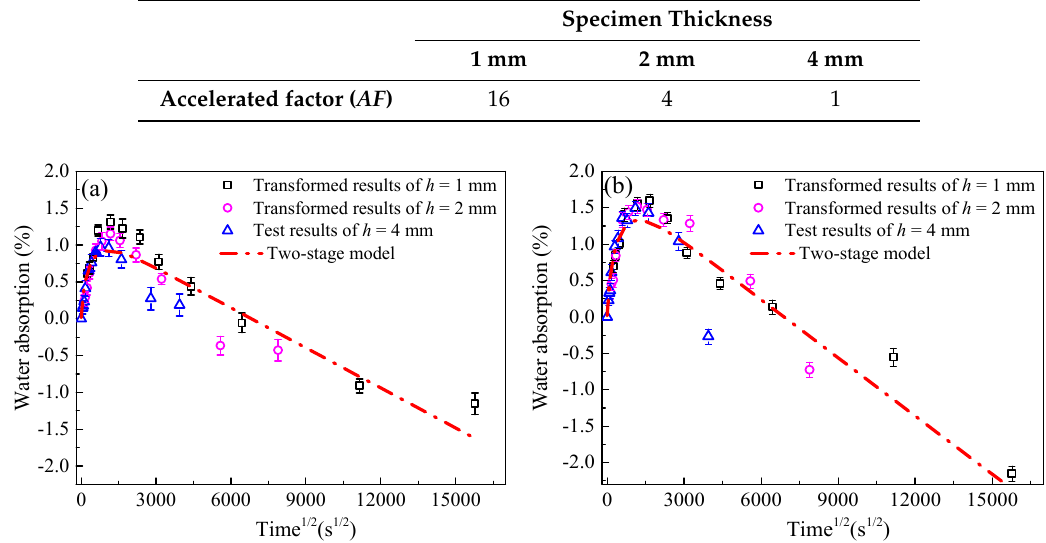
Figure 16. Accelerated ageing results of water absorption based on specimen thickness in ( a ) deionized water and ( b ) alkaline solution.